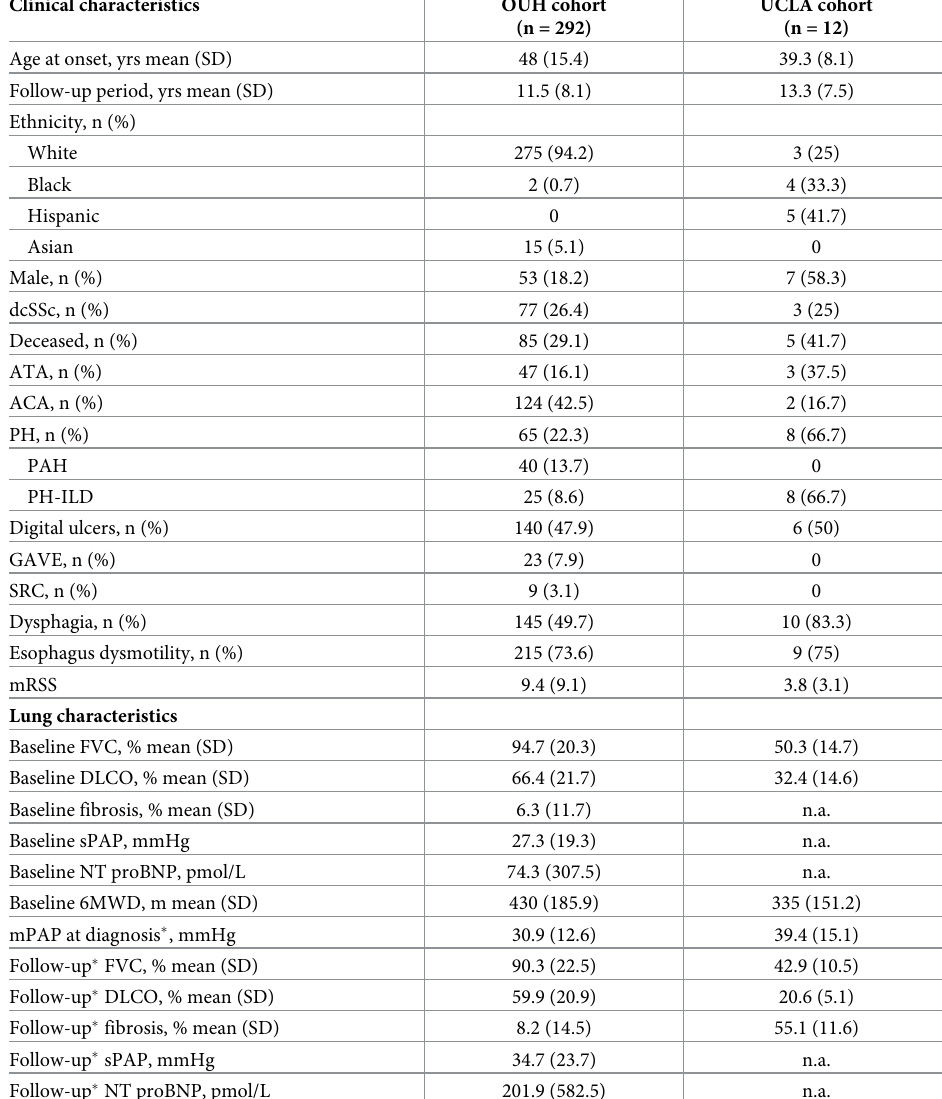
Table 1. Demographics and clinical characteristics from the Oslo University Hospital and the University of Cali- fornia at Los Angeles. Clinical